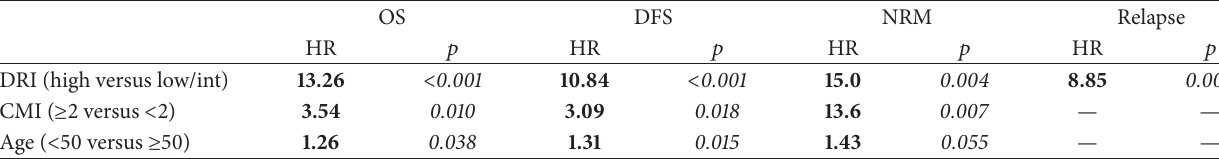
Table 1: Predictors of transplant outcomes following MA haplo